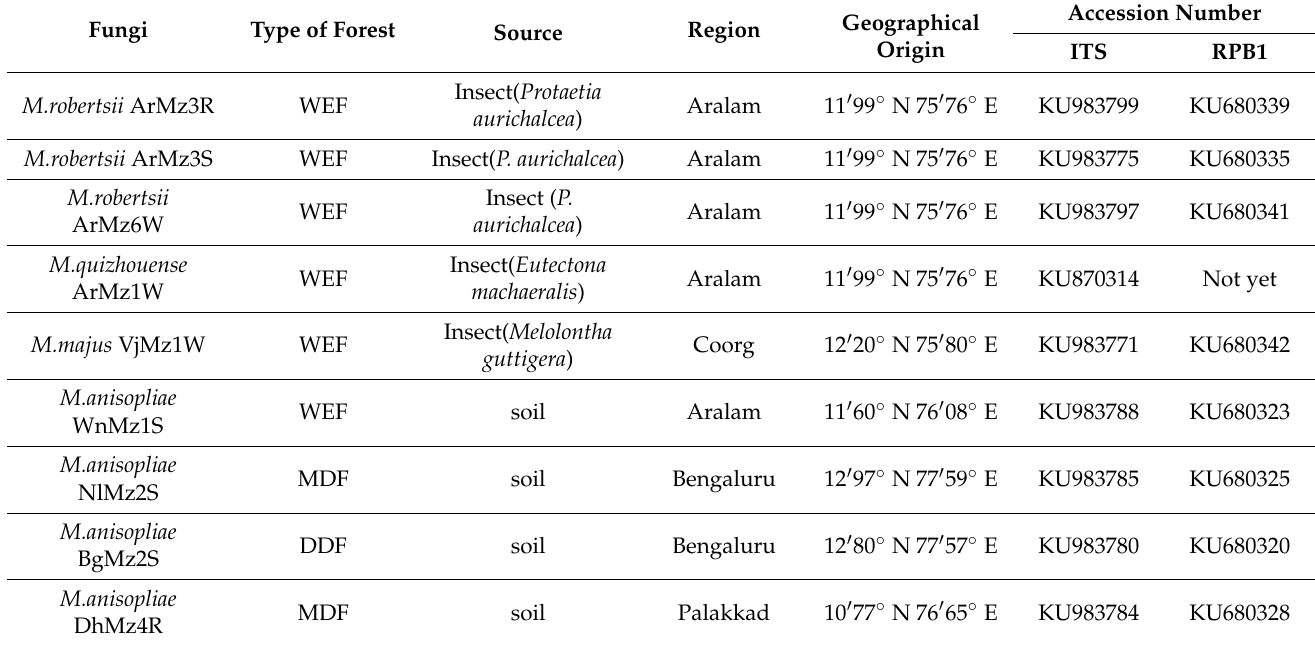
Table 1. List of Metarhizium spp. Isolates obtained and sequenced for phylogenetic